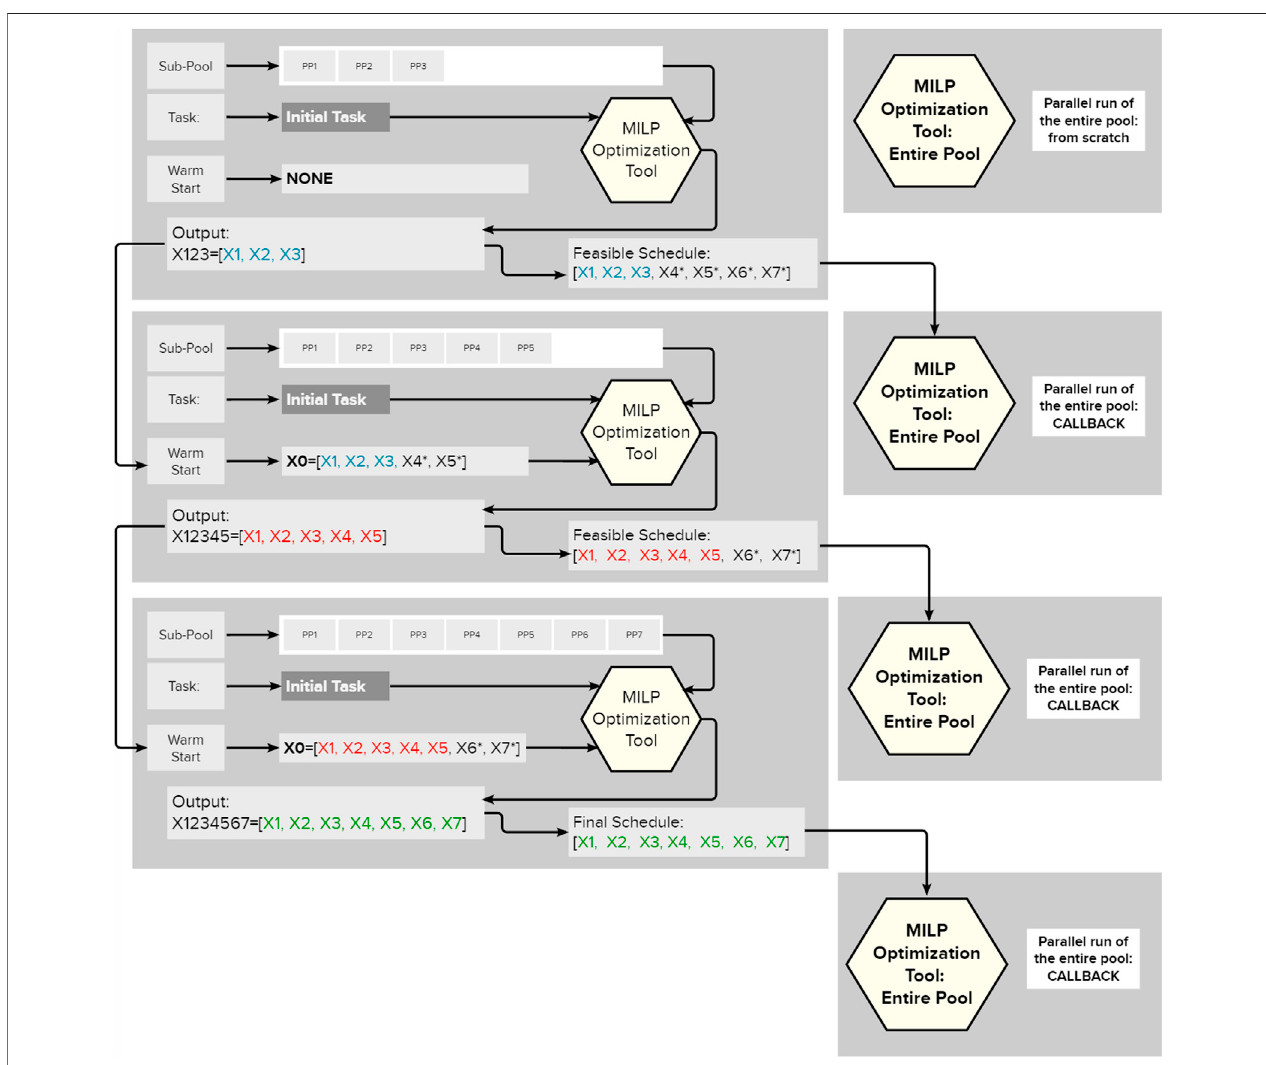
FIGURE 2 | The visualization of the Gradual Increase methodology with a callback.